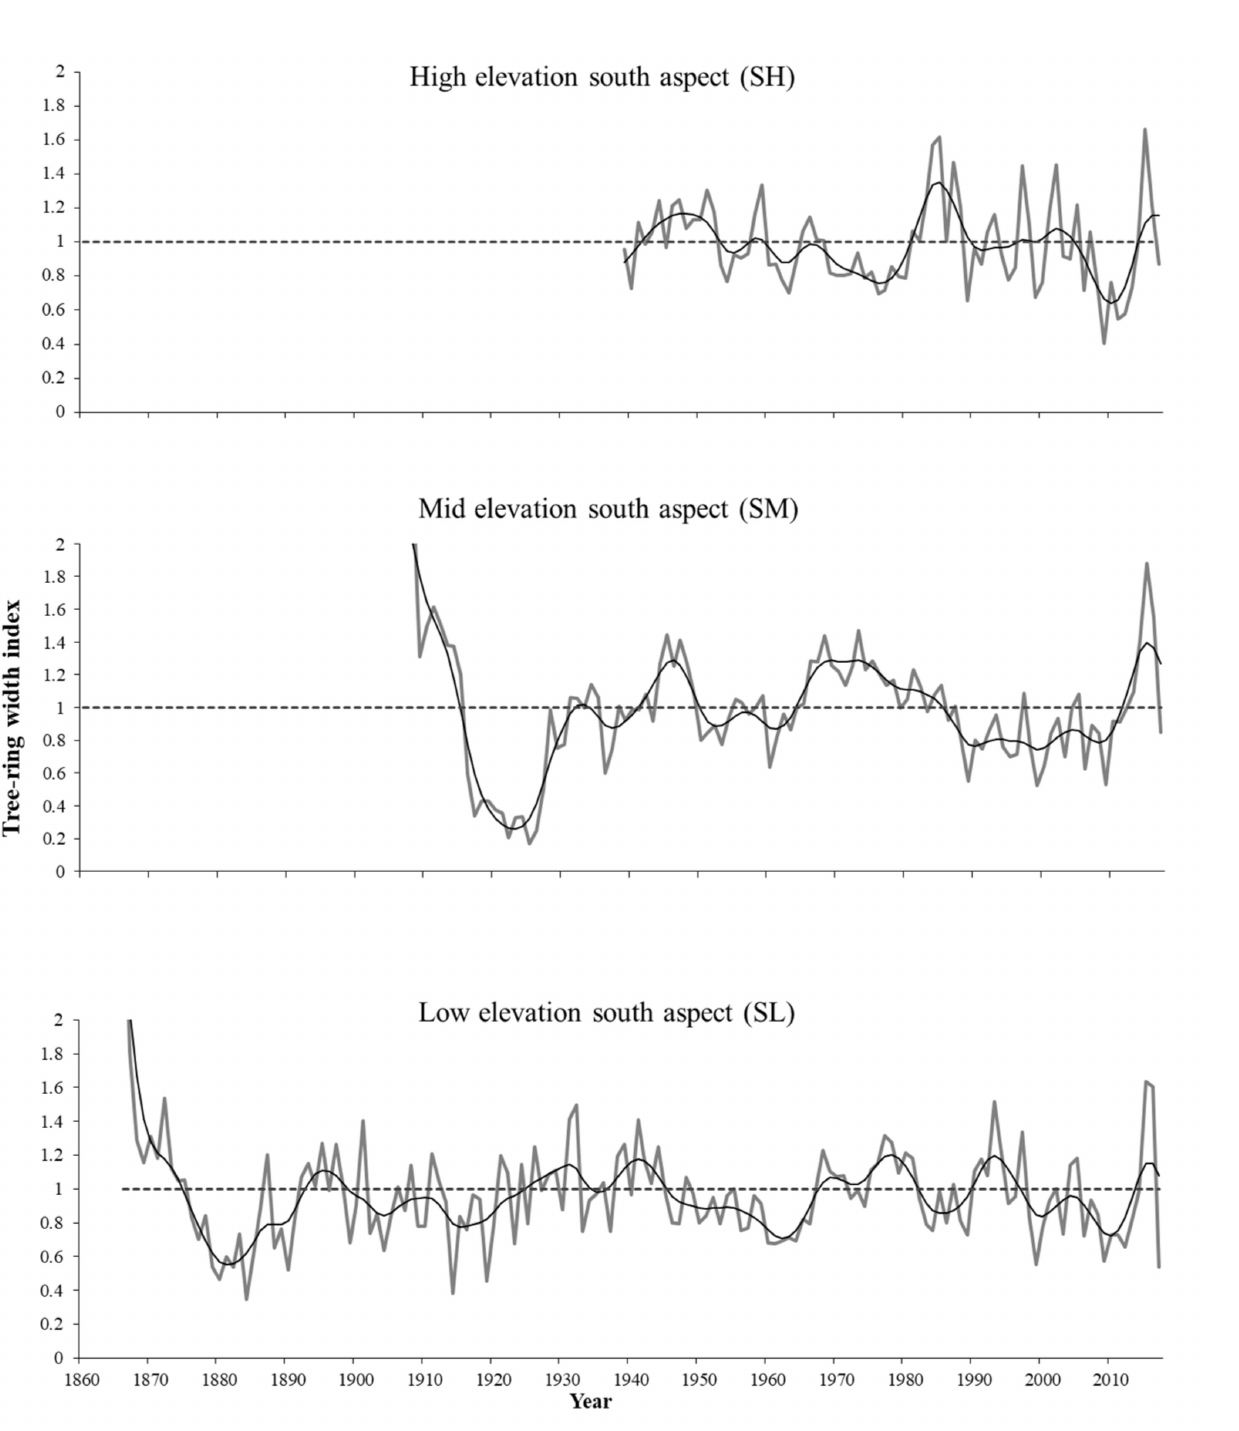
Figure 4. Ring-width chronologies of A. jaliscana in the south aspect of the mountains in western Jalisco, Mexico. The gray line corresponds to the annual ring-width indices; the flexible line is a decadal spline to highlight low-frequency events, and the dotted line is the mean of the ring- width